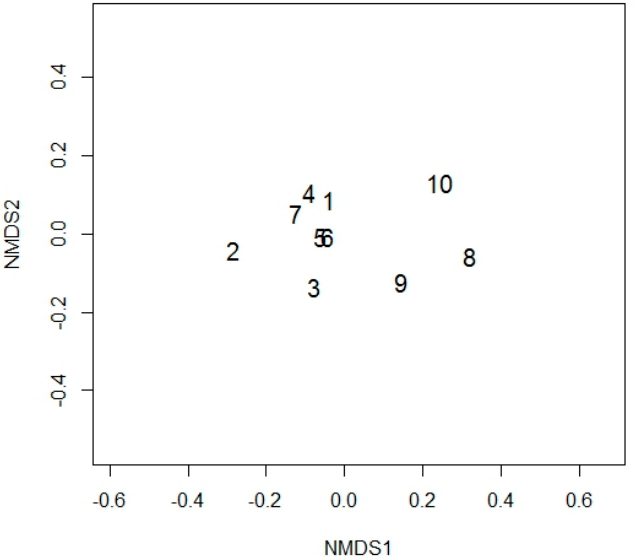
Figure 2. Non-metric multidimensional scaling of the communities found within roots from the ten plants sampled within site III, stress was <0.05. Created in R version 3.4.3. Table 2. The 48 OTUs that were present in all plants from site III and their identification. Names of organisms are given according to Species Fungorum (http://www.indexfungorum.org/; accessed on 1 February